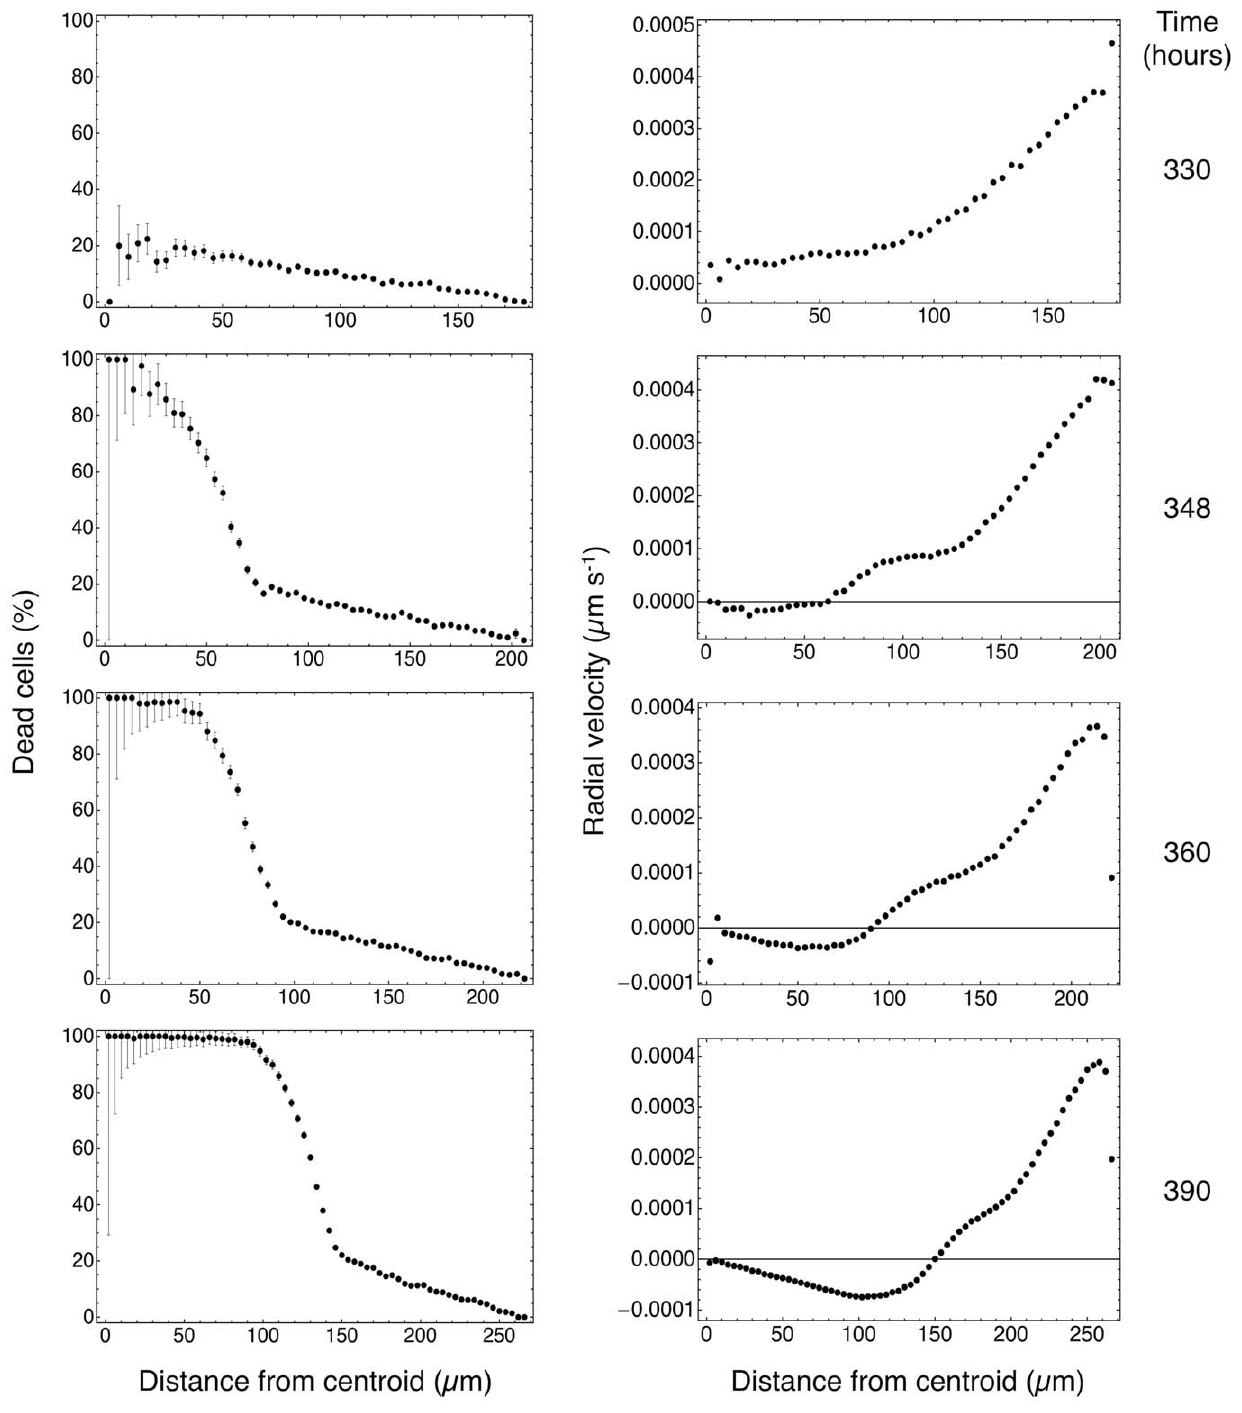
Figure 7. Fraction of dead cells (left column) and average radial velocity (right column) at different times. As the spheroid grows, the necrotic core becomes increasingly well defined, and as dead cells shrink, the radial velocity changes sign and a marked inward motion characterizes the central region.